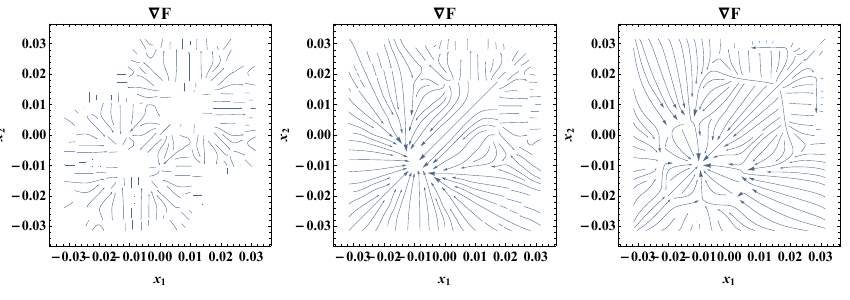
Figure 6. Evolution of the potential F distribution for the times 0, 7 and 28 days respectively.